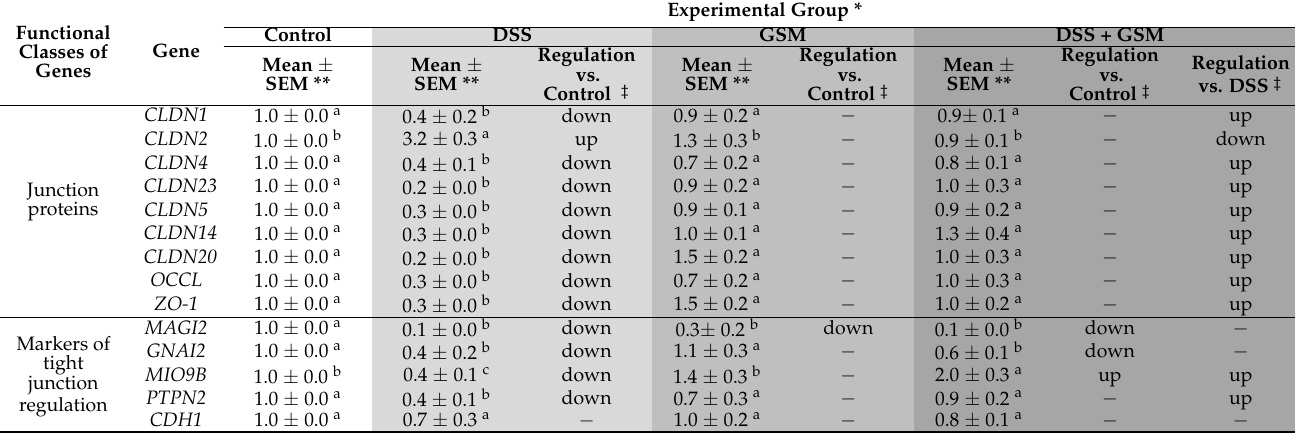
* Unchallenged and DSS-treated pigs were assigned for 30 days to a control diet (Control and DSS groups) or 8% GSM diet (GSM and DSS + GSM groups). At the end of the experiment, colon samples from all animals ( n = 5) were collected and analyzed for gene expression by qPCR. ** the expression of target gene was normalized to the geometric mean of two reference genes; the results, expressed as fold changes (Fc) are presented as mean ± SEM. ‡ Anova-one way followed by Fisher tests were used to analyze the effect of experimental treatments on mRNA expression, and p < 0.05 was considered statistically significant; up: up-regulation, down: down-regulation, -: no effect. a,b,c Groups with unlike superscript letters were significantly different ( p <